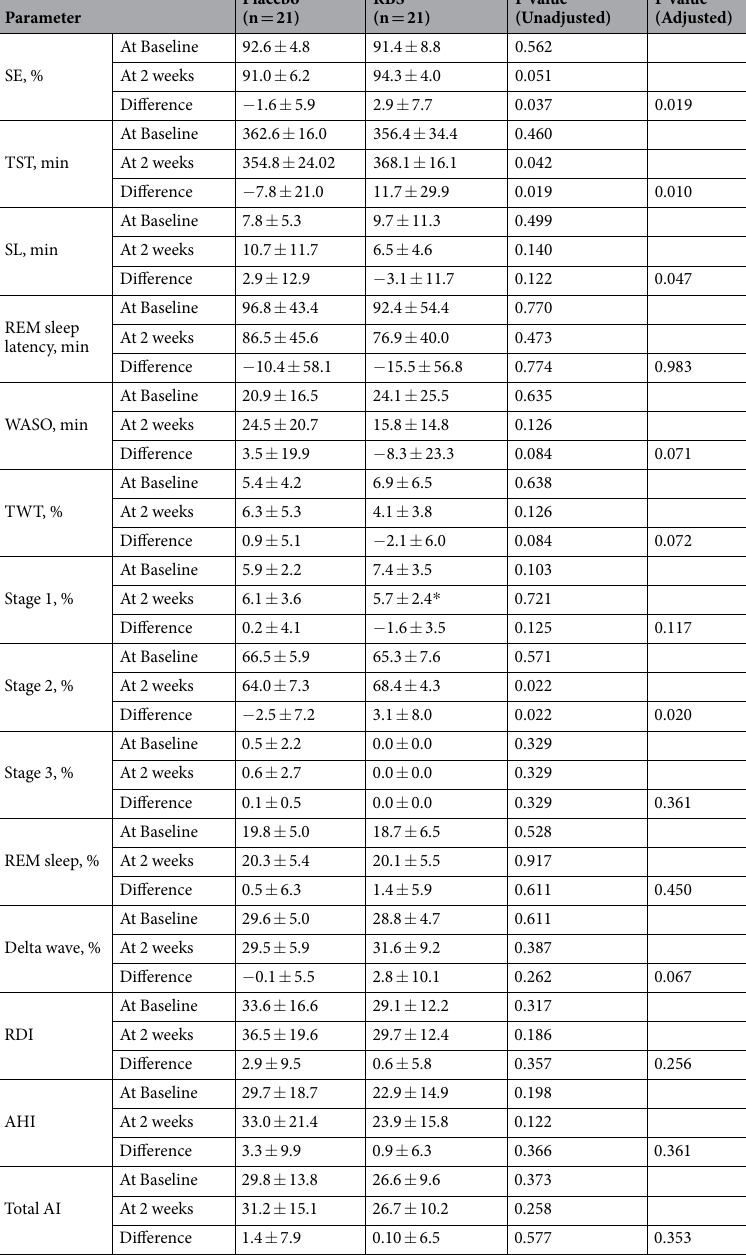
Table 3. Objective sleep parameters analysed by PSG. Data are expressed as the mean ± standard deviation. * Within-group comparison, paired t-test, P < 0.05. a P values refer to independent t-tests, compared with the placebo group. b P values refer to the analysis of covariance, adjusted for caffeine intake as a